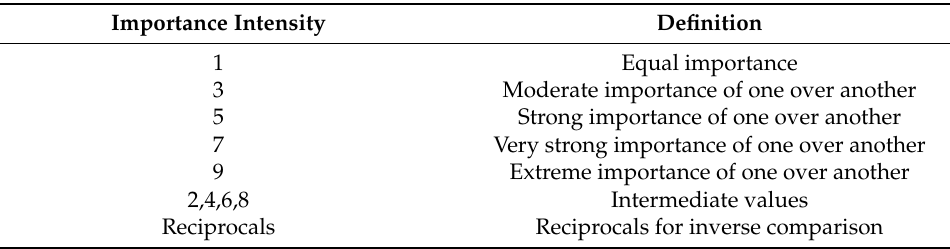
Figure 7. Hierarchical model for selecting the optimal scheme. Table 4. The 1~9 scales for pairwise comparisons in the AHP [33].